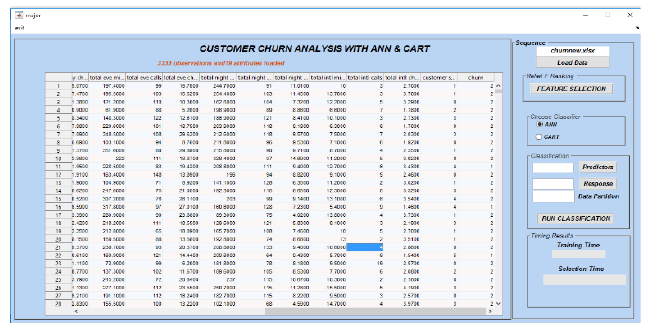
Figure 2. Loaded Telecom Customer Churn